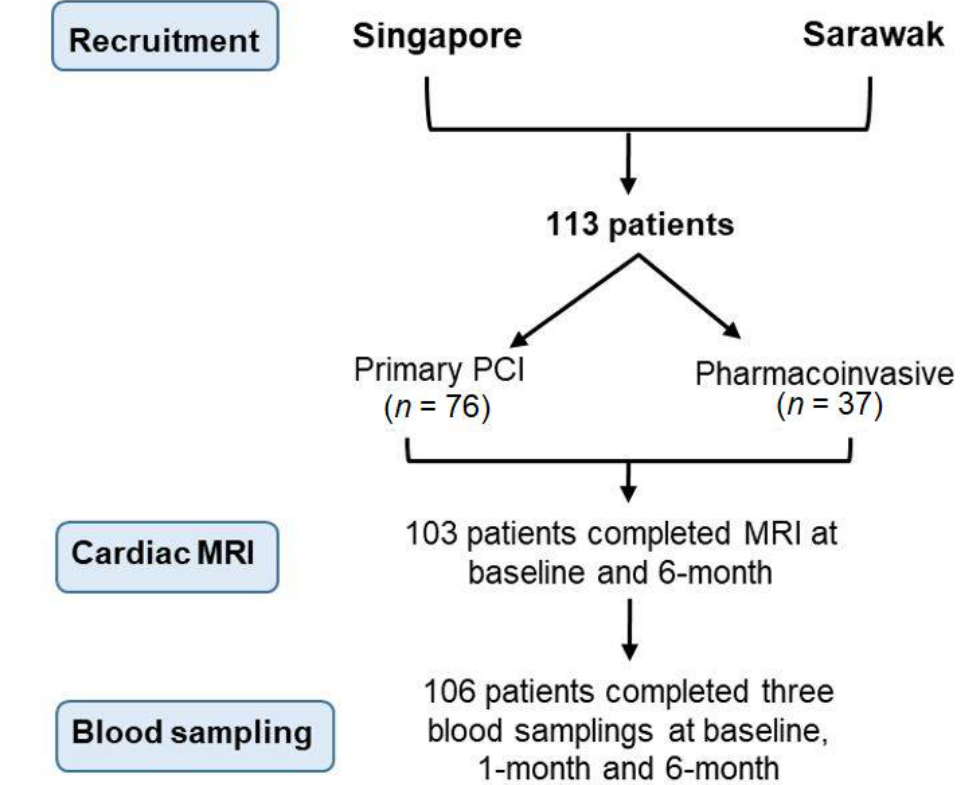
Figure 2. Flow diagram describing the patients recruited in the study.